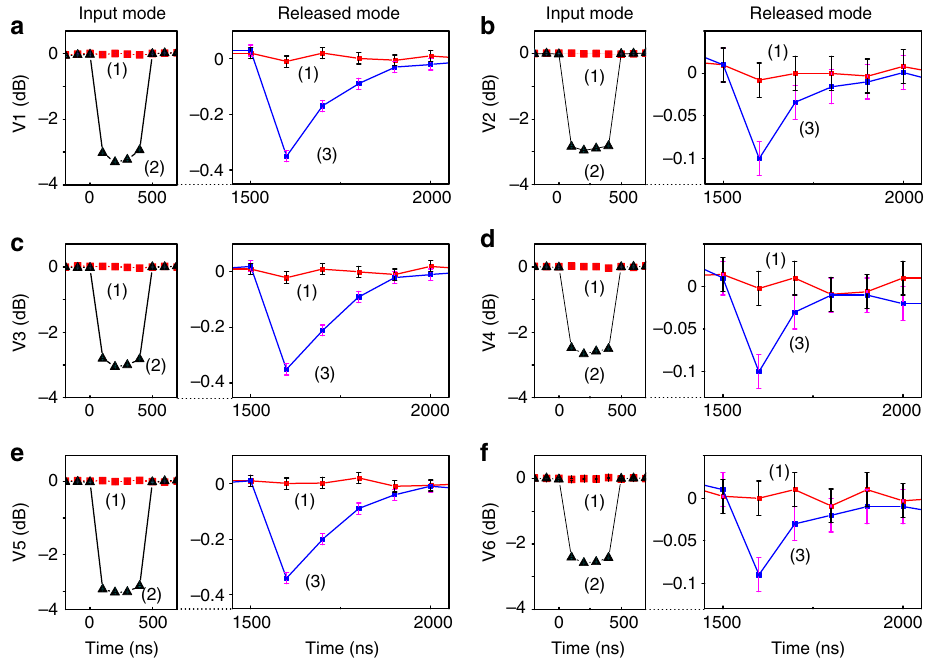
Fig. 3 Measured normalized correlation variances of input and released optical submodes. Trace (1) is the vacuum noise level. Trace (2) is the correlation variances of the original input optical submodes. a V1 ðh δ 2 ð ^ X ð 0 Þ